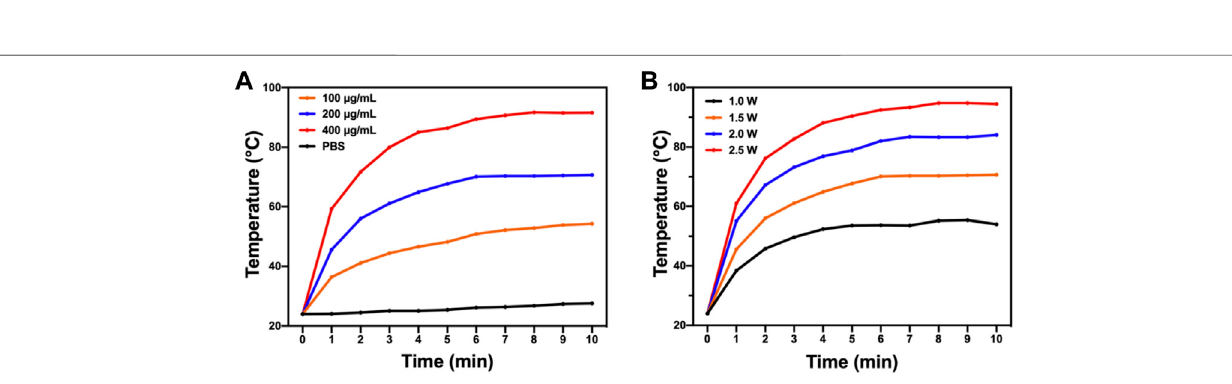
FIGURE 5 | Optical property of BAPTCDs. (A) UV-vis spectrum of BAPTCDs. The insets are the photograph of BAPTCD aqueous solution under visible light (left) and UV light with the wavelength of 365 nm (right). (B) Fluorescence emission spectra of BAPTCDs.